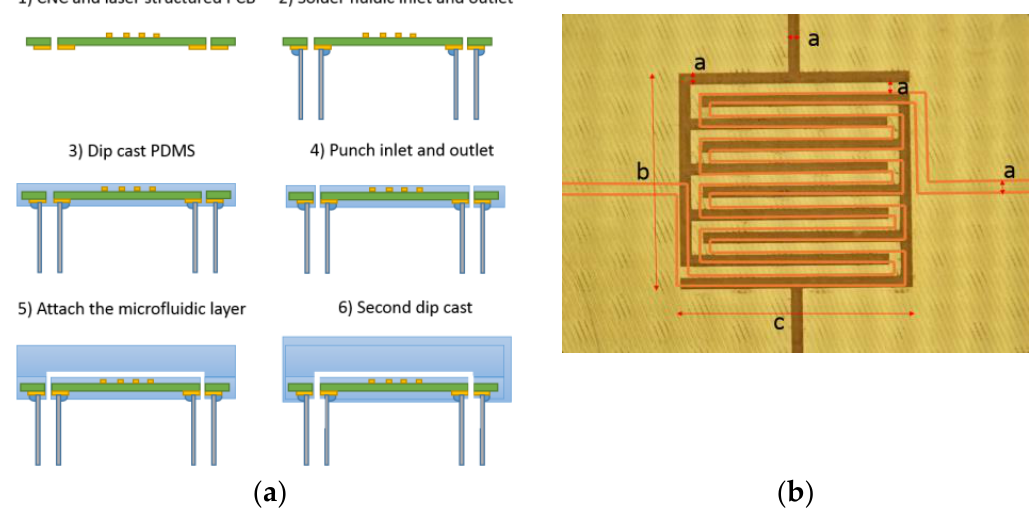
Figure 4. ( a ) Sensor processing steps; ( b ) sensor dimensions (a = 0.25, b = 4.75, and c = 5 mm) and highlighted fluidic channel as orange line.